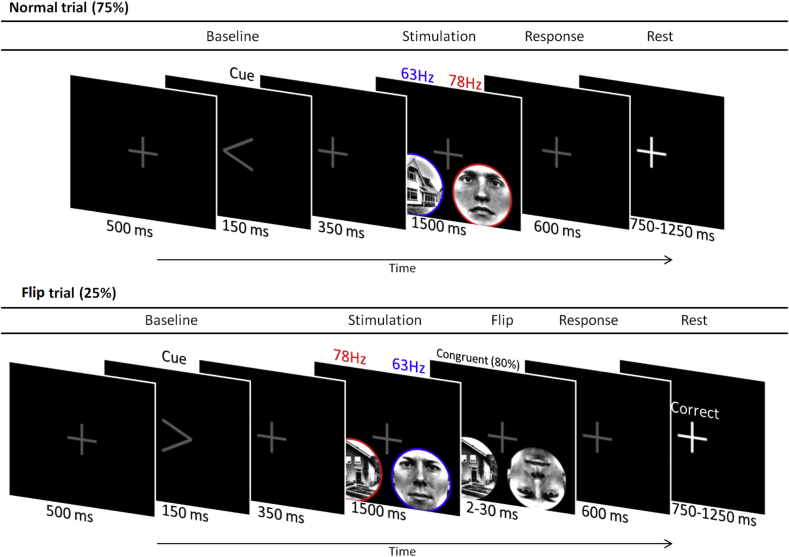
Schematic representation of the experimental paradigm. After an attentional cue, a house-face pair was presented at 63 and 78 Hz (counterbalanced over trials). In 20% of the trials, one of the images was flipped vertically and required participant's response. In 5% of the trials (catch trials), the flip was in the hemifield opposite to the cued side and participants had to ignore this event.